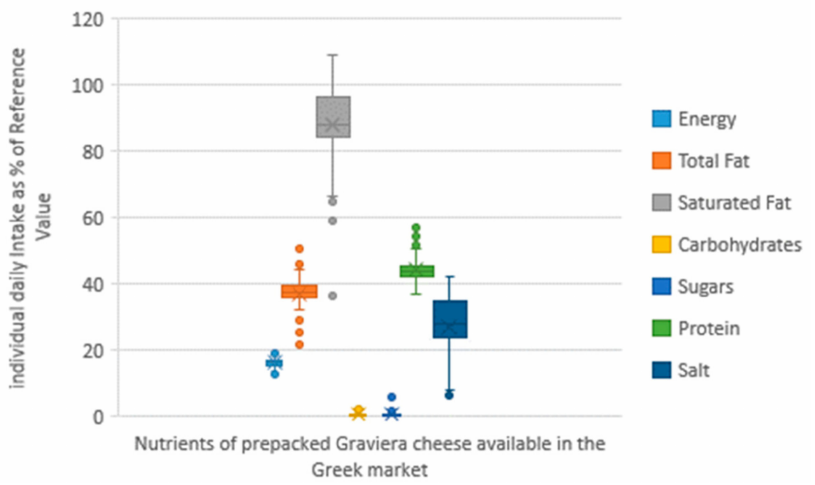
Figure 6. Daily intake per capita as a percentage of European Daily Reference Intakes (RIs) for the 95th percentile of the daily consumption of pre-packed graviera cheese marketed in the Greek